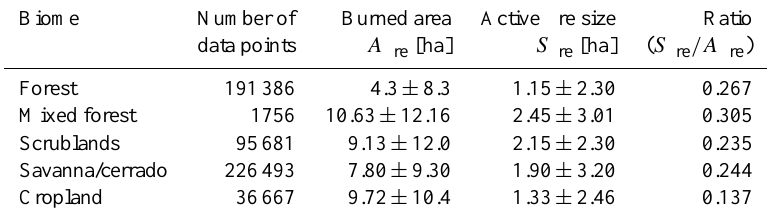
Table 2. Table of fire area and size, derived from MODIS FRP measurements for the 2012 Brazilian fire season. Biome Number